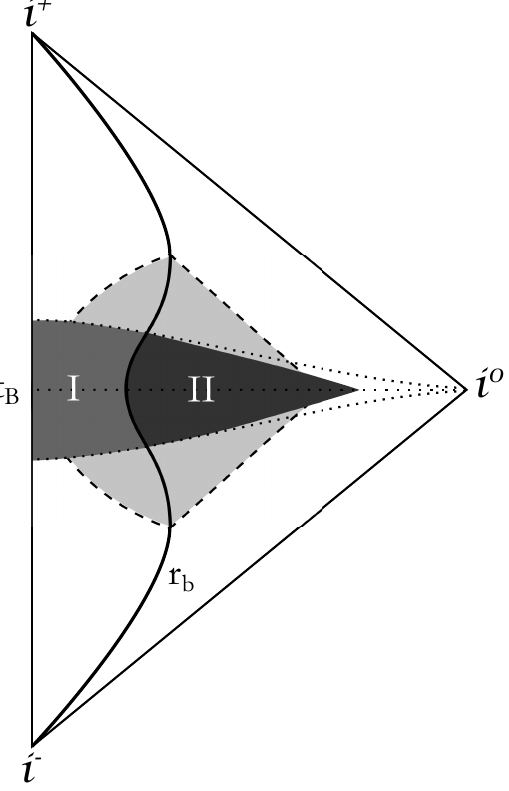
Figure 1. Penrose diagram of a generic black hole bounce: the boundary of the cloud (thick line r b ) separates the interior from the exterior. Initially, there are no deviations from the classical scenario. The apparent horizon develops in the interior and the black hole horizon in the exterior (dashed lines). The QG dominated regime develops in the interior (region I, drawn here for an homogeneous matter cloud, for which the QG regime is reached by all shells at the same co-moving time) and possibly propagates in the exterior (region II). Depending on the model, region II may vanish, may extend to a finite distance outside r b or may even extend to spatial infinity. The way the horizons are affected depends on the specifics of the model. After the bounce (which, in the homogeneous case, occurs at the same co-moving time t B for all shells), the solution is described by the time reversal of the collapsing